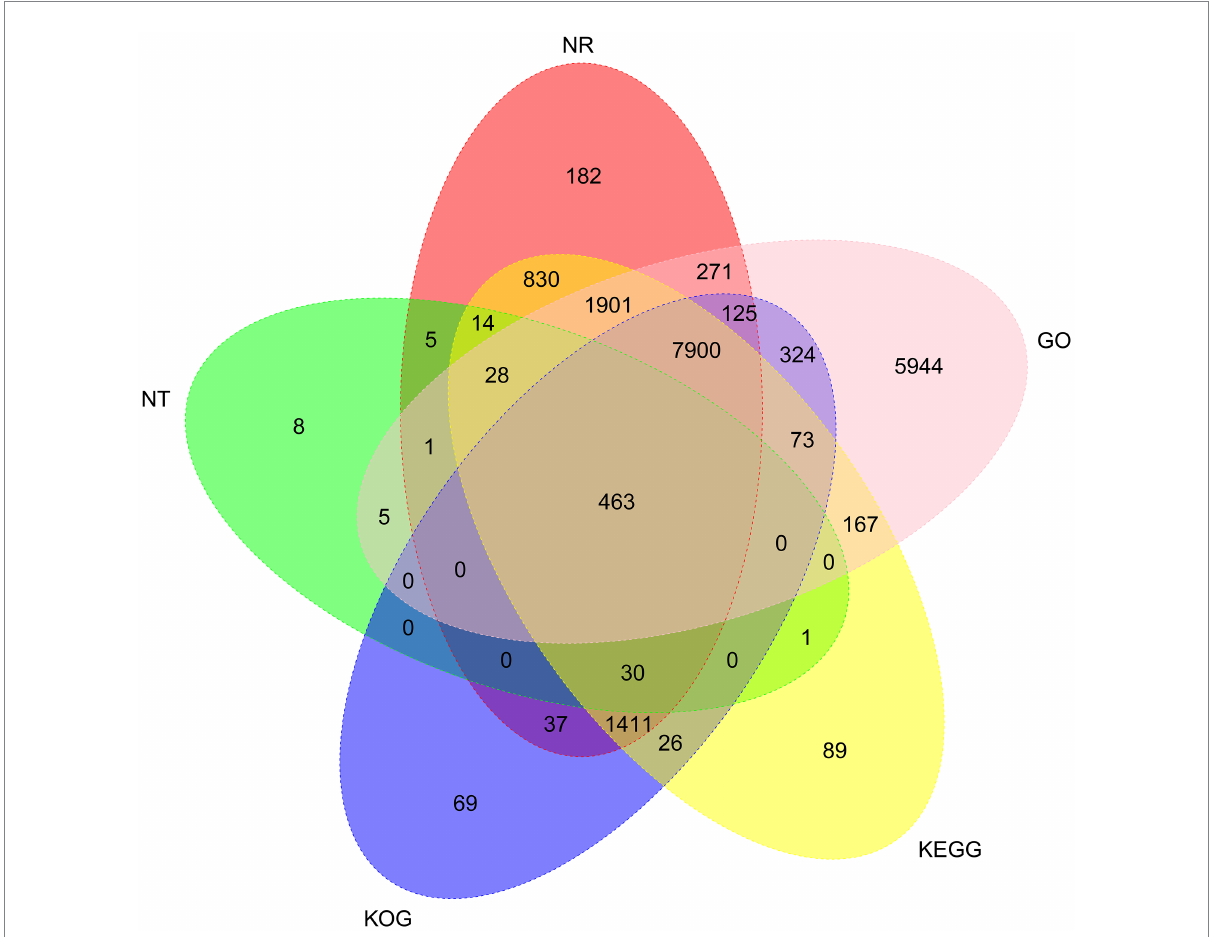
FIGURE 2 Venn diagram of NR, NT, GO, KOG, and KEGG annotation of the Akashiwo sanguinea full-length